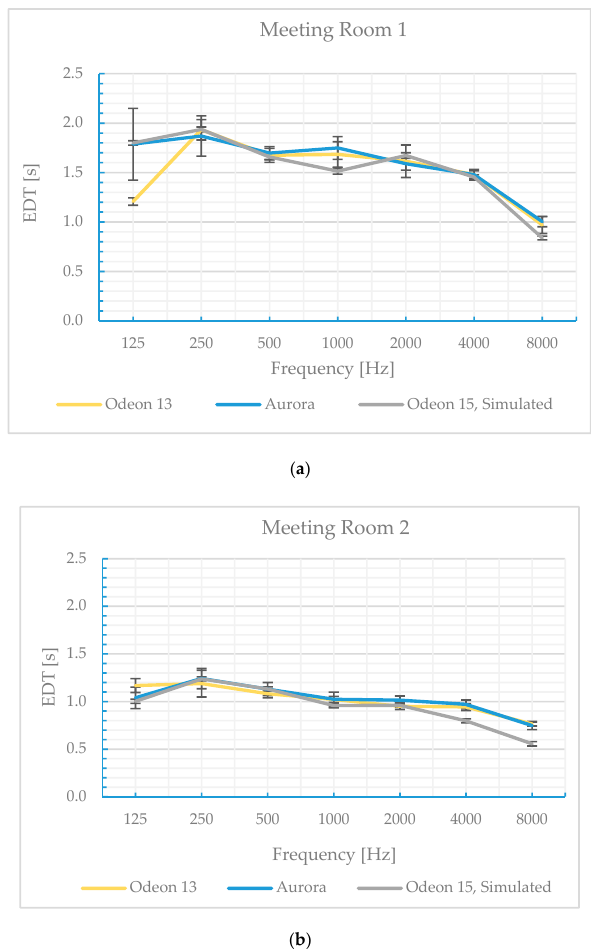
Figure 8. Octave band early decay time (EDT) measured in the Mr1 ( a ) and Mr2 ( b ) with ODEON 13 Room Acoustic Measurement System and the Aurora plug-in, version 3.0. The error bars represent the standard deviation across different measurement positions.